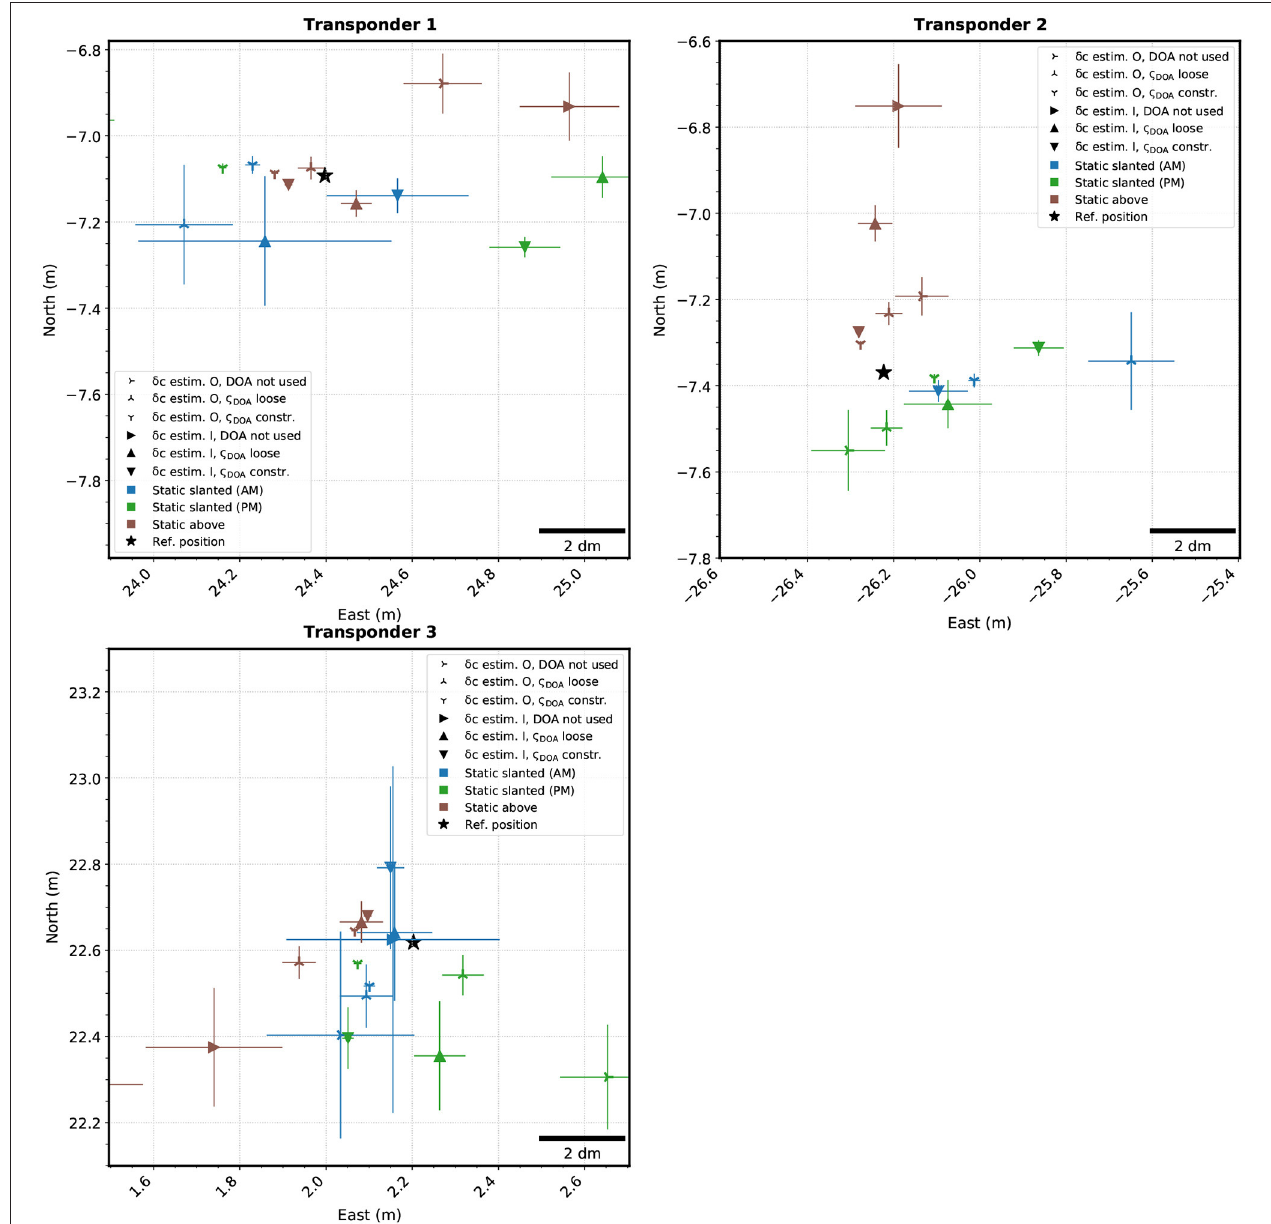
FIGURE 7 | Positions of the three transponders based on the static acquisitions. The symbols represent the different parameterizations and the colors the acquisition modes (static-slanted in the morning or the afternoon, and static-above). The horizontal and vertical bars are LSQ formal standard deviations. The black stars ( H ) represent the real-time solutions provided by the USBL/INS system after box-in (see section 4.2). For δ c estimation, “I” stands for used, and “O” for not used. Few outlier solutions are outside the